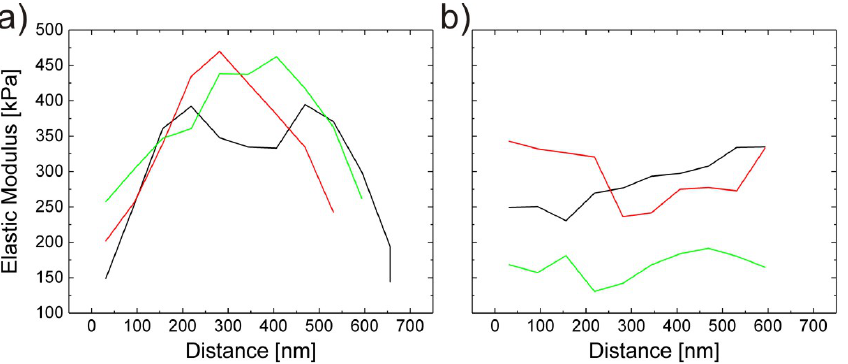
Figure 5. Elastic moduli of ( a ) core-shell microgels (batch method) and ( b ) homogeneous microgels (feeding method) measured across the cross section (force map) for three individual microgel particles. Taken from